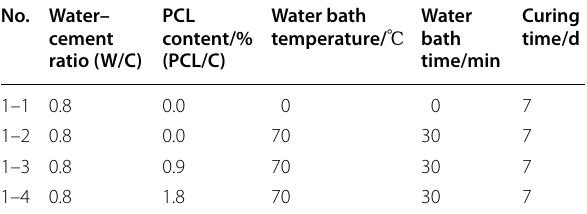
Table 2 Cement paste mix design and preparation